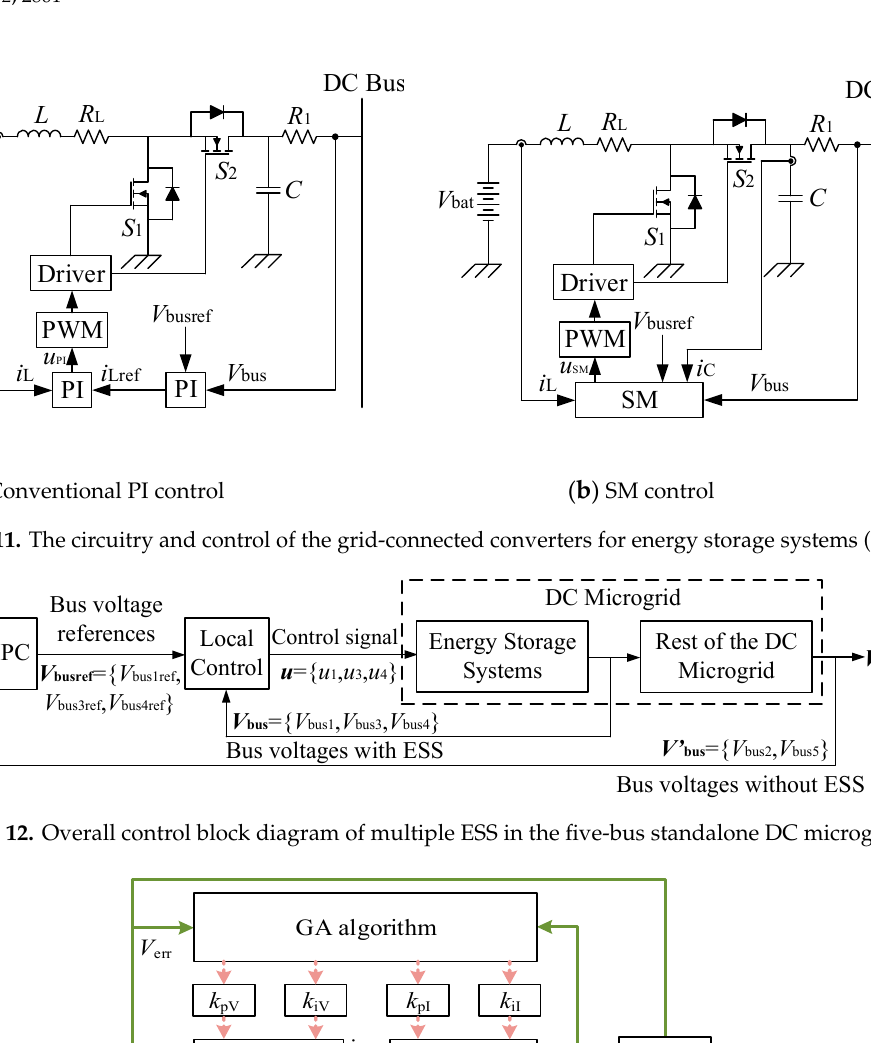
Figure 14. The energy loss reduction of the DC microgrid with PI and SM control. ( a ) Bus 1